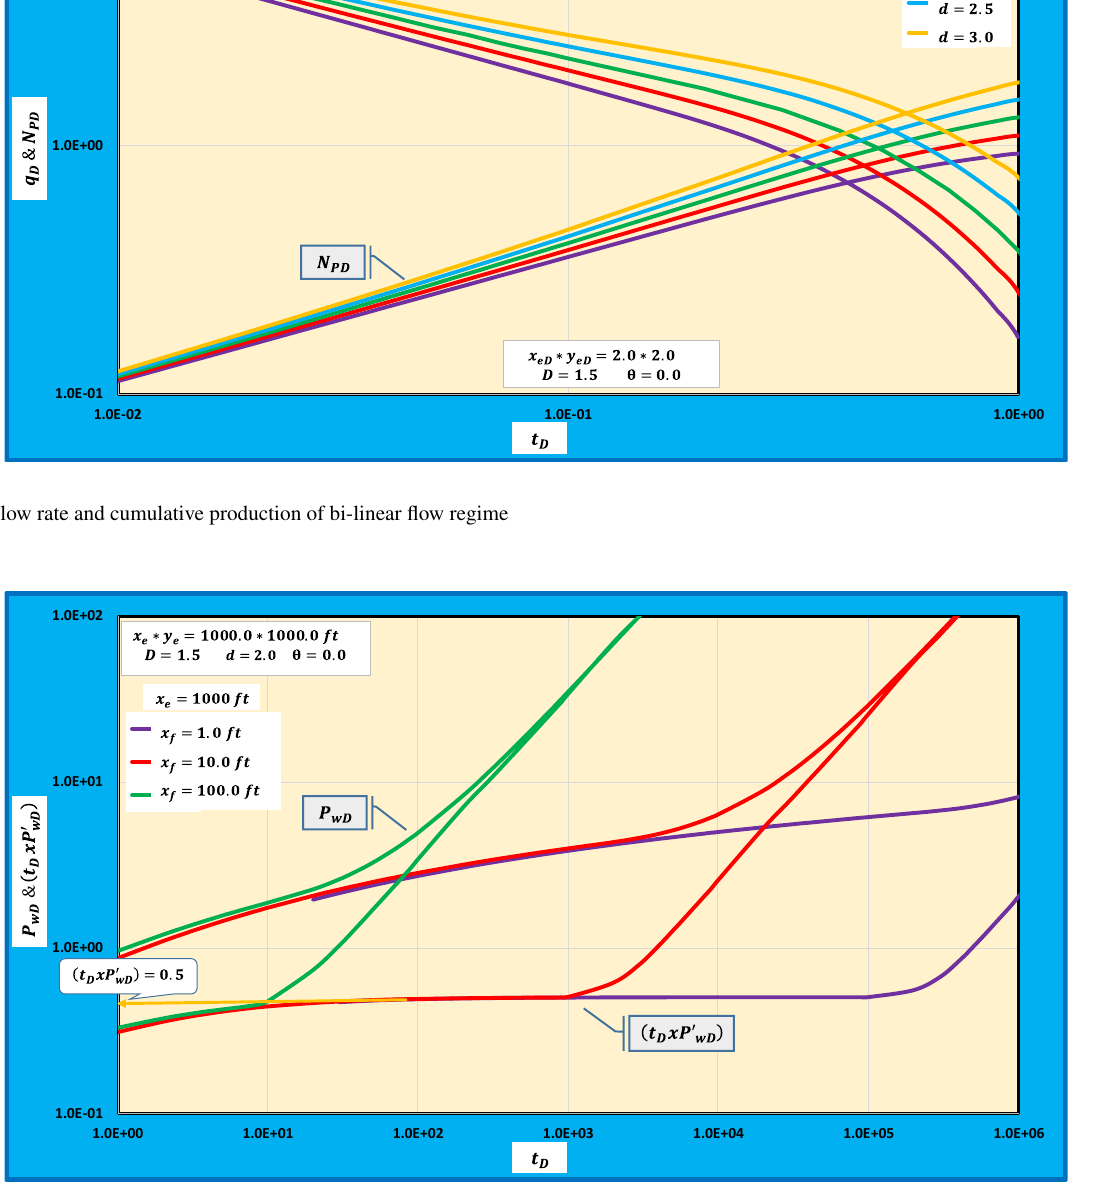
Fig. 23 Pressure and pressure derivative of the pseudo-radial flow regime for different hydraulic